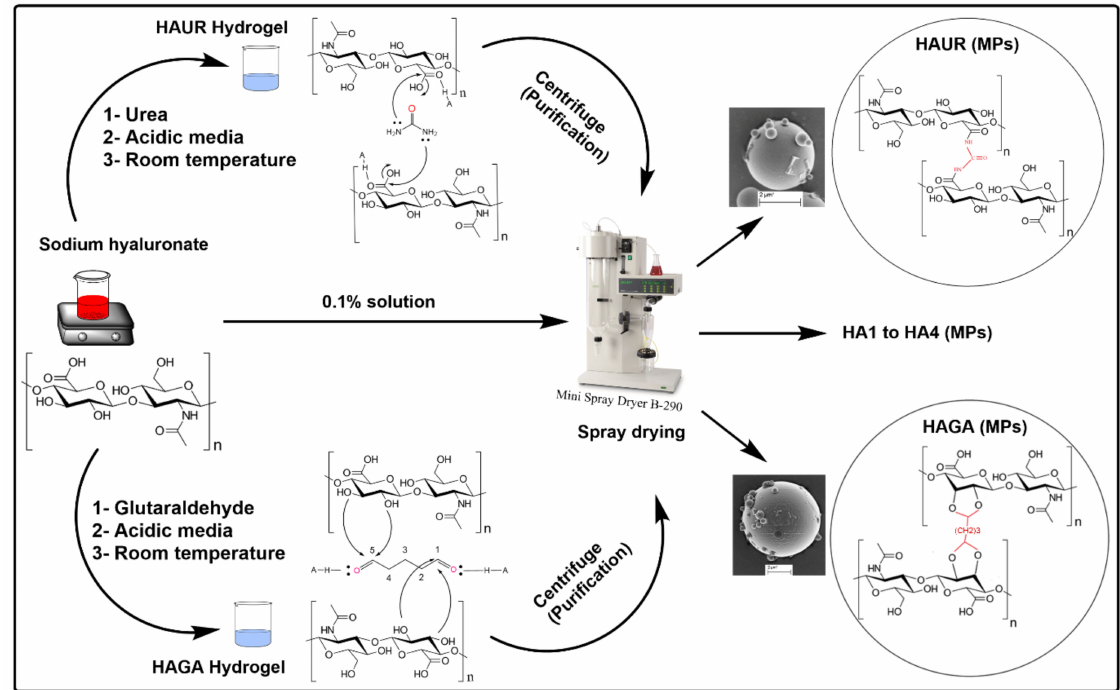
Figure 1. Schematic representation of the preparation of HA-based microparticles (MPs) along with the chemical reaction mechanisms for crosslinking with urea (UR) and glutaraldehyde